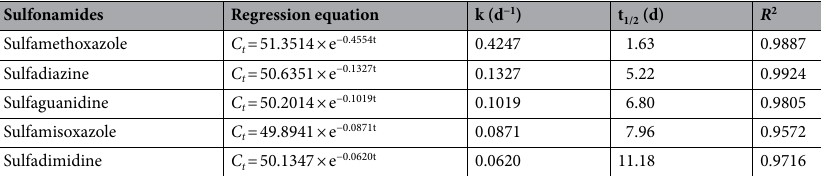
Table 3. Kinetic parameters of various sulfonamides degradation by S. mizutaii LLE-5. k represents degradation constant (d −1 ); t 1/2 represents half-time (d); R 2 represents correlation coeffificient; Ct is the concentration (mg/L) of sulfonamides at time t.